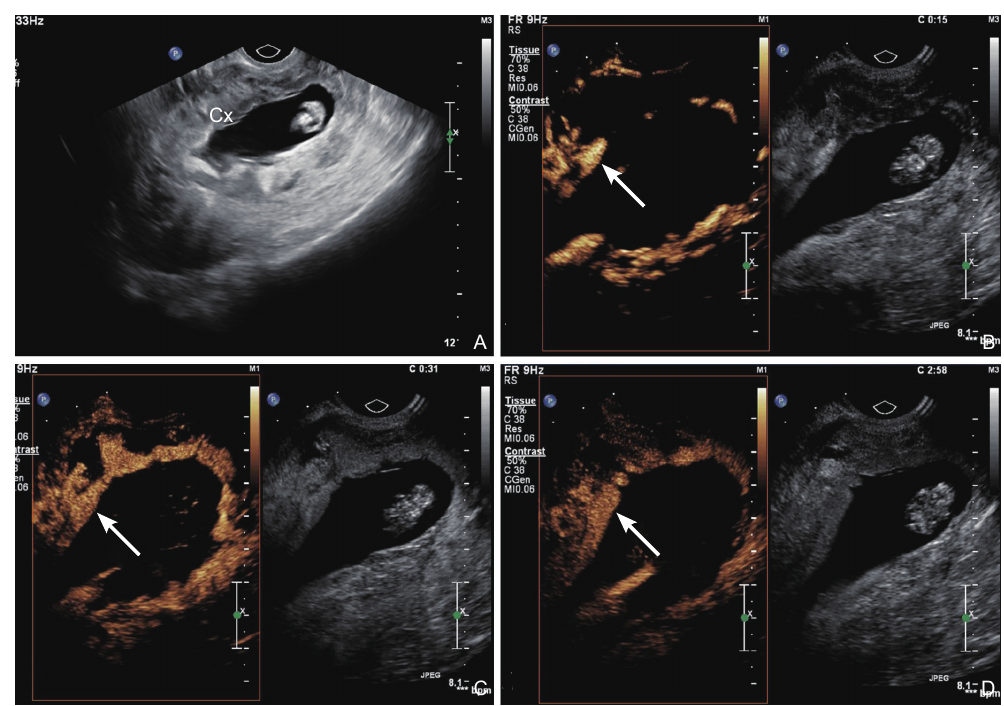
Figure 1 Ultrasonographic findings of Case 1. (A) Transvaginal ultrasonography showed the presence of a gestational sac with embryo at the cervix canal; (B) The right image shows the fundamental mode, and the left image shows the CEUS mode. The wall of the gestational sac showed rapid enhancement during the early enhancement phase with the performance of hyper-enhanced (white arrow); (C) Enhancement with the sign of doughnut- shaped in the wall of the gestational sac (white arrow); (D) Contrast agents washed out slowly during the late enhancement phase (white